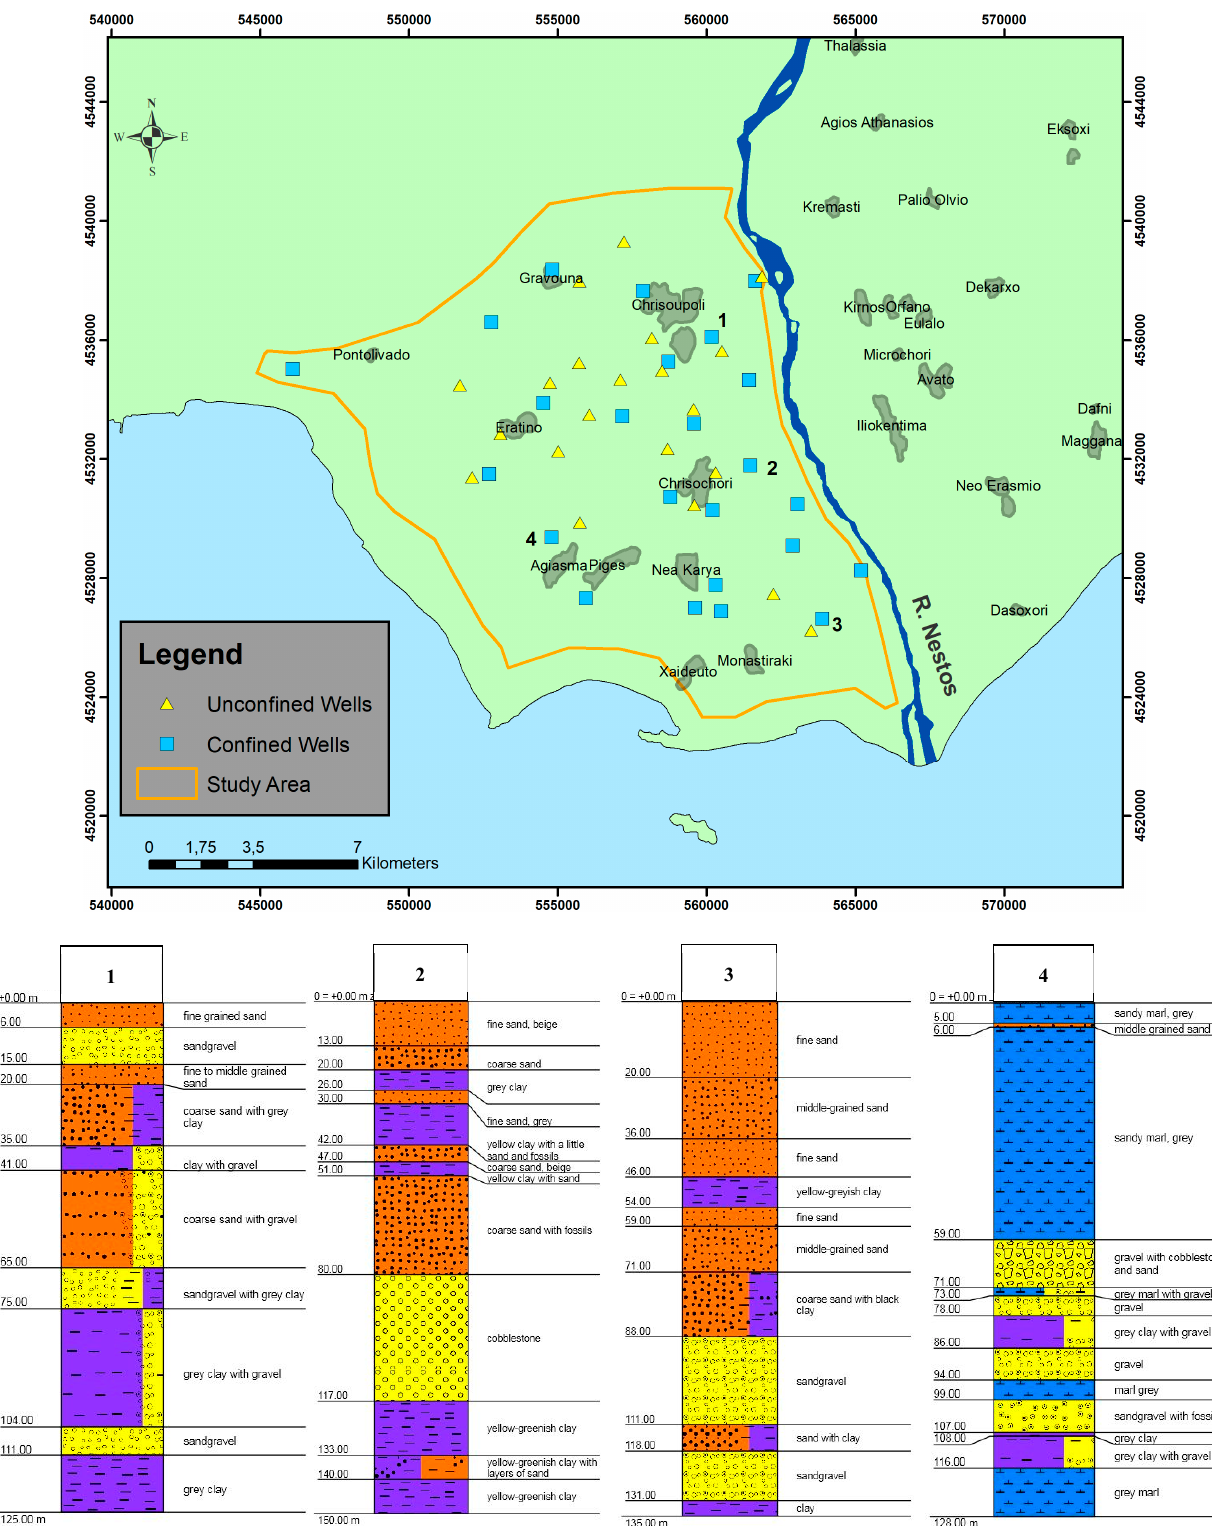
Figure 3. Monthly rainfall charts from Chrysoupolis meteorological station.